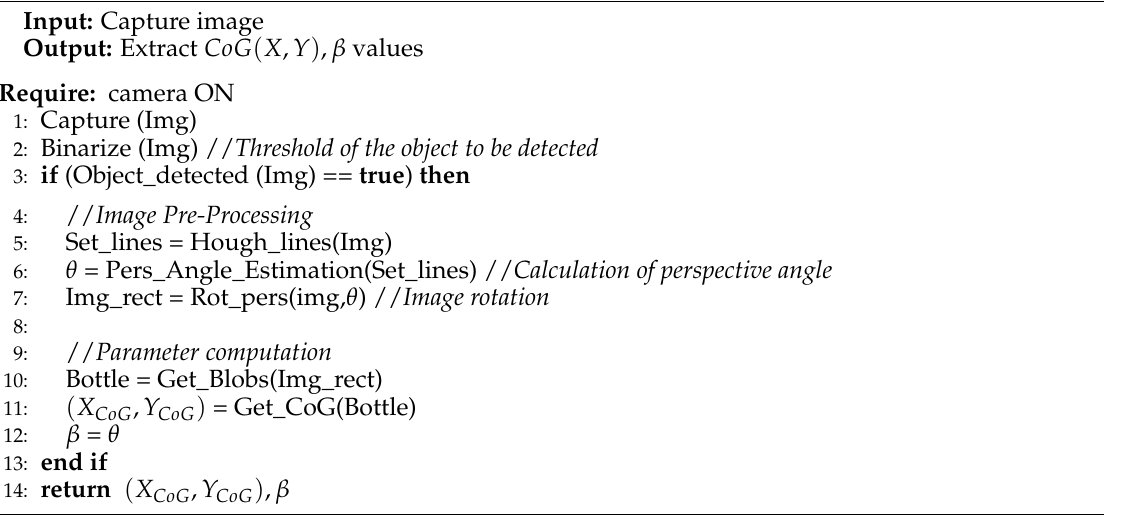
Algorithm 1 Data acquisition by modifying the image nature. (Figure 6